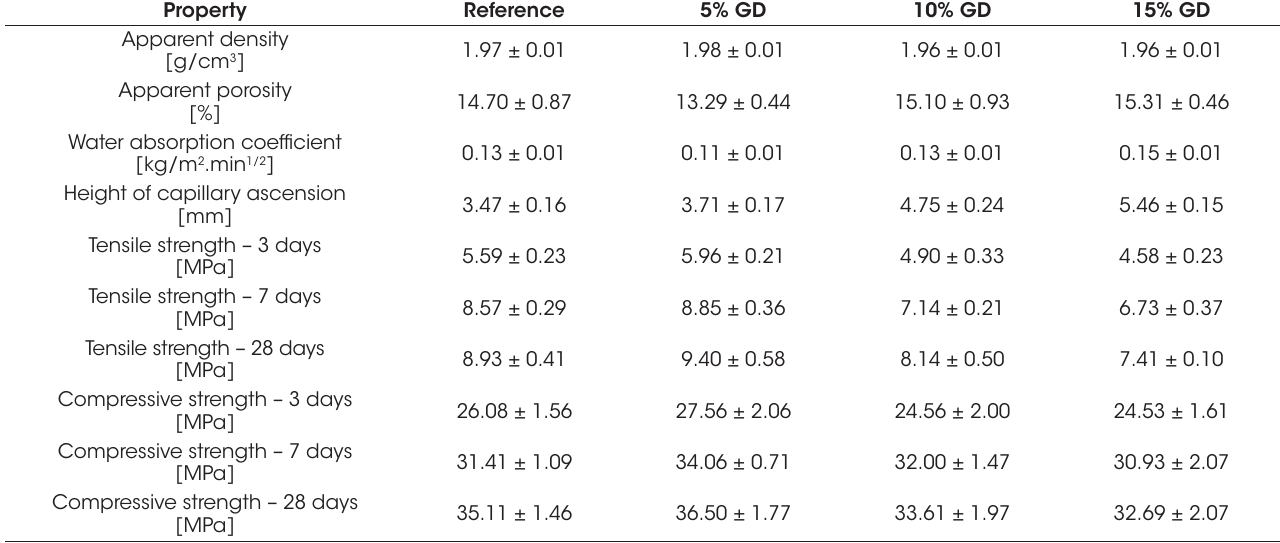
Physical and mechanical properties of the cementitious matrices with varying grinding dust (GD) addition